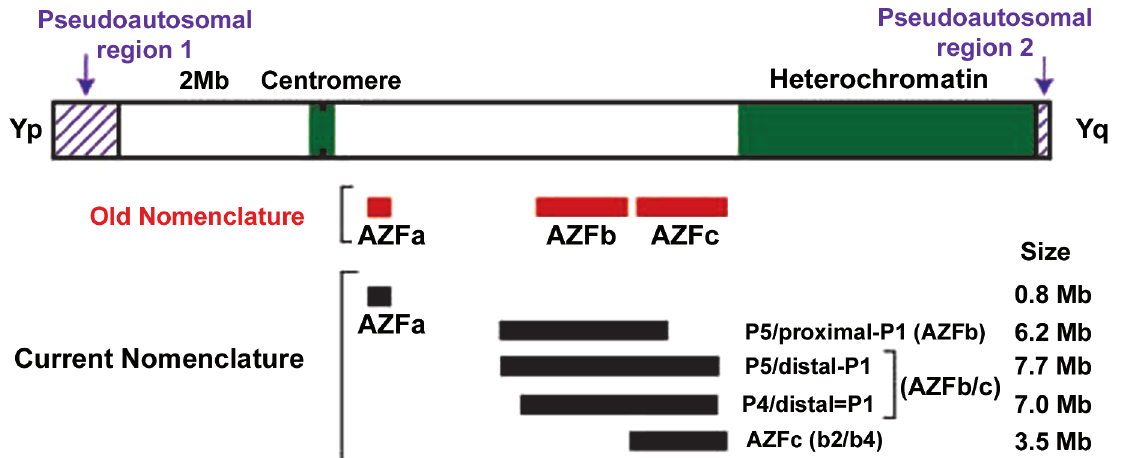
Figure 1 – Illustration of the Y chromosome in humans and the regions involved in fertility and infertility. Interstitial or terminal dele- tions that include AZFa, often mediated by recombination between the HERV15yq1-HERV15yq2 repeats, usually produce the severe phenotype of Sertoli-cell-only syndrome. Interstitial or terminal deletions that include AZFb and/or AZFb+c (hereafter designated AZFb/c) are mediated by recombination between palindromic repeats, either P5/proxP1, P5/distP1, or P4/distP1. These deletions usu- ally result in azoospermia. Interstitial or terminal deletions that include AZFc only are mediated by recombination between the b2/b4 palindromic repeats and result in a variable phenotype, ranging from azoospermia and SCOS to severe or mild oligozoospermia. This type of deletion can occasionally be associated with normal fertility in younger males, with the phenotype worsening with age. Such individuals should consider cryopreservation of ejaculated sperm in early adulthood. Two partial deletions of AZFc, called b1/b3 and gr/gr, are considered polymorphisms. (Adapted from Am J Hum Genet. 71(4), Repping S et al., Recombination between Palindromes P5 and P1 on the Human Y Chromosome Causes Massive Deletions and Spermatogenic Failure, pages: 906-22, Copyright 2002, with permission from